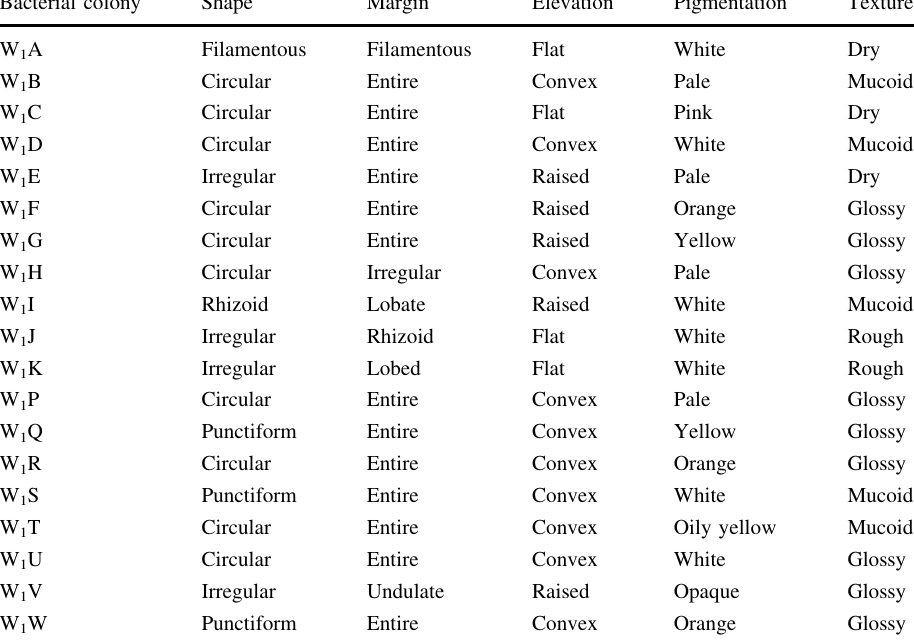
Table 2 Morphological characterization of the isolated strains from waste dumping